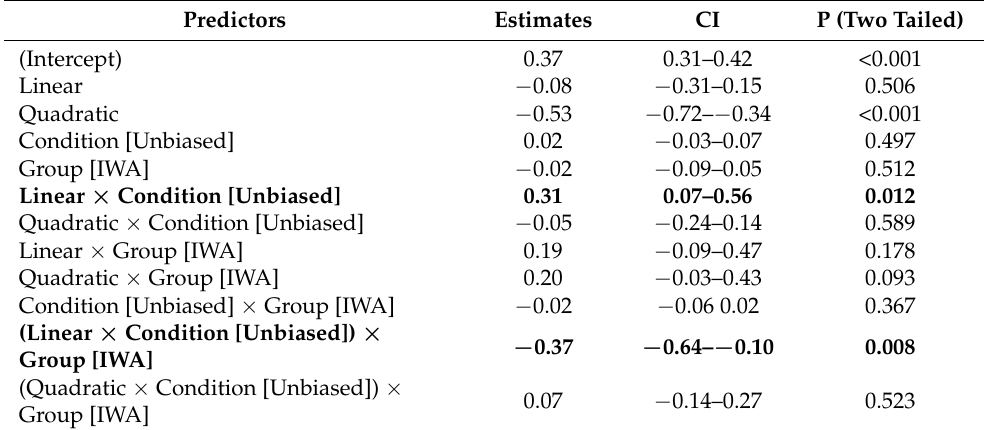
Table 4. Results of GCA analysis for time window 1 (processing